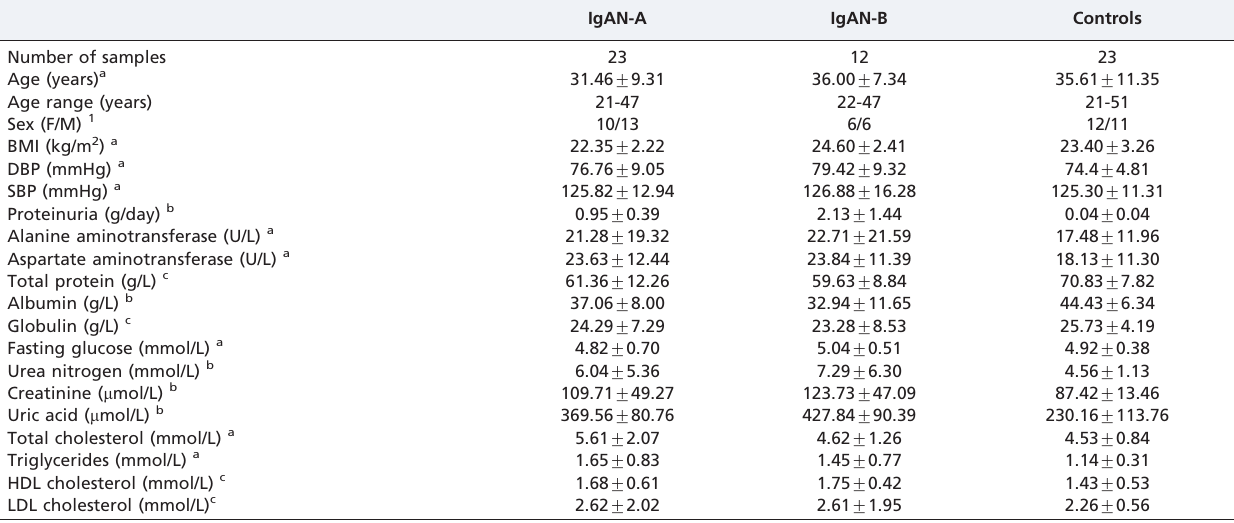
Table 1 - Demographic and clinical patient characteristics.